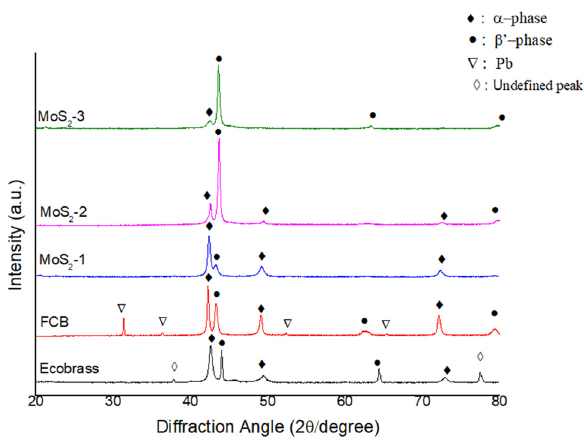
Figure 1: XRD pattern results of samples on spectrum.